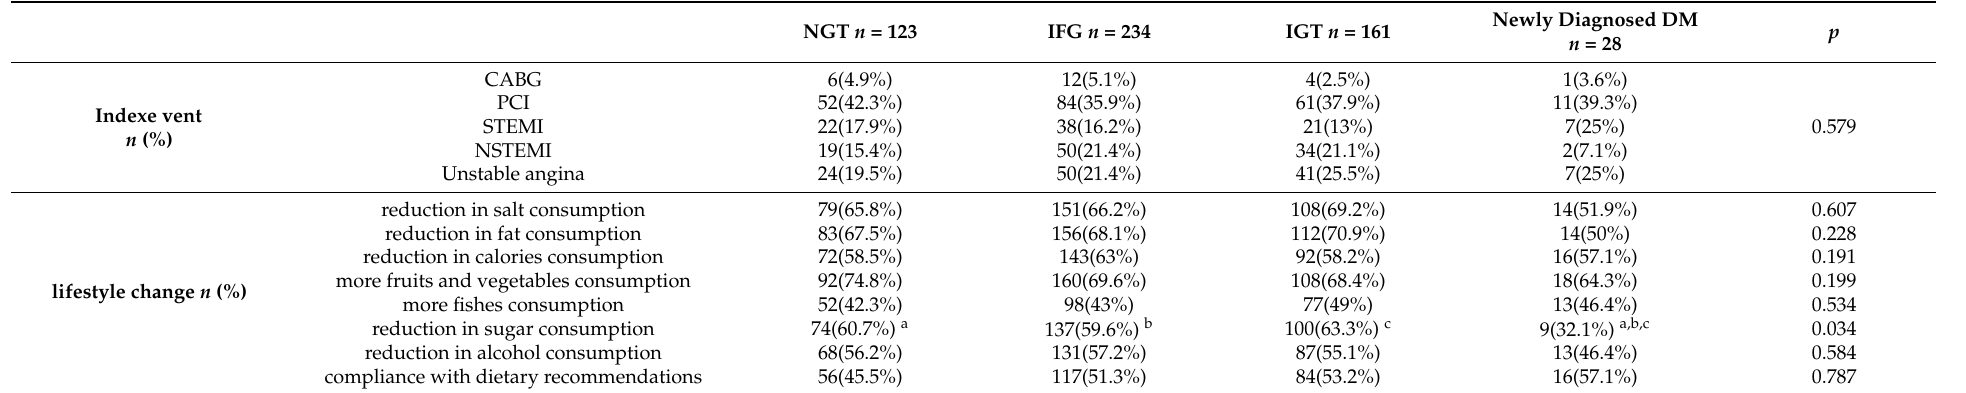
Table 3. Index event and lifestyle changes in groups of patients according to